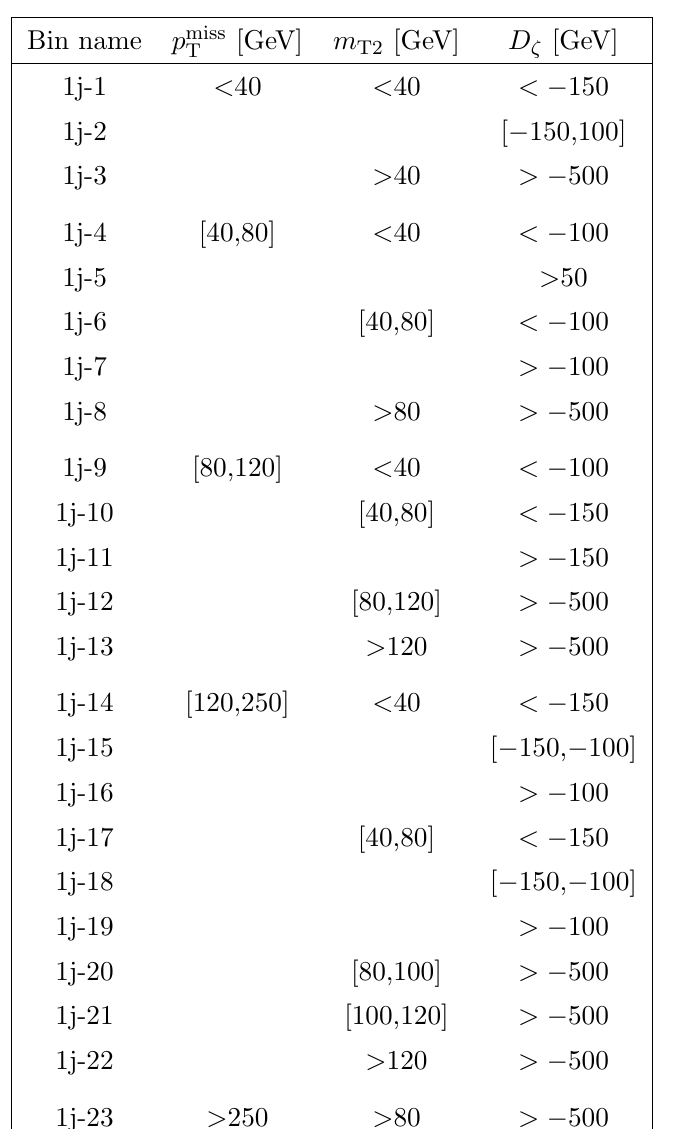
Table 5. De(cid:12)nition of SRs in the 1-jet category for the e (cid:28)